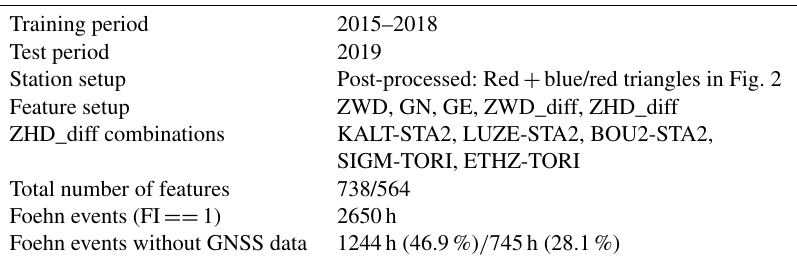
Table 8. Default setup used for FS3 and FS4. For features not outlined in a specific row, by default, all stations and combinations of stations are